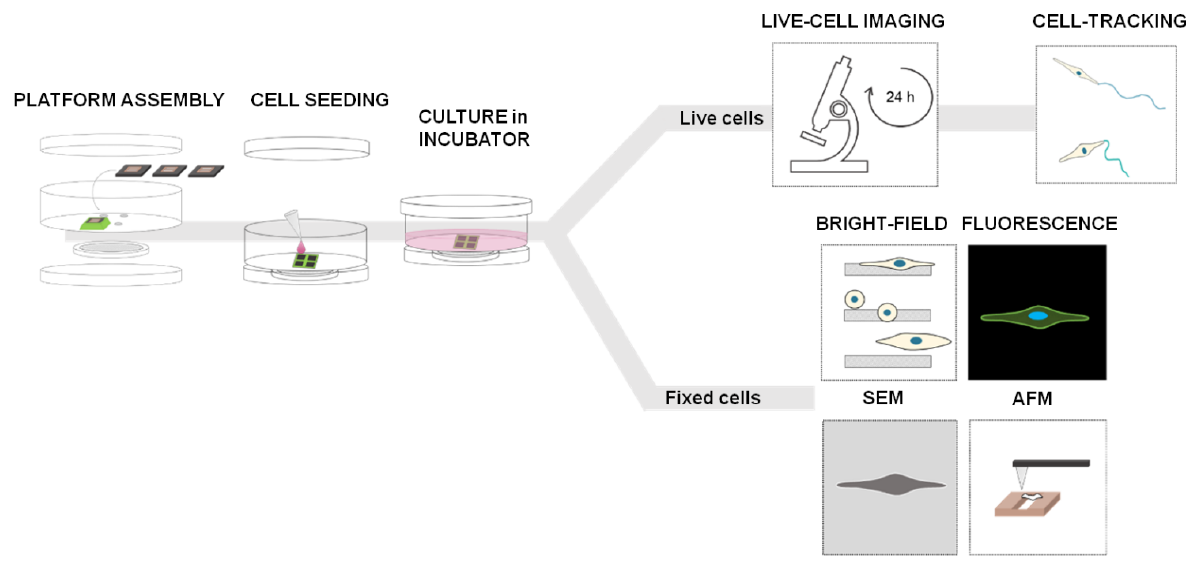
Figure 2. Experimental workflow with the 2D micro-patterned system—4 holes are created on the bottom of a commercial petri dish (35 mm of diameter) using the laser cutter instrument and each chip is fixed on each hole with a biocompatible glue with the top side facing up; cell seeding—a 25 µ L drop of cell suspension is placed on the chip surface and incubated for 20 min in incubator (37 ◦ C and 5% CO 2 ) to allow cells to adhere, while the bottom side beyond the gap is kept dry; the petri-dish is filled with the medium (2 mL final volume) and the chamber is sealed using a petri dish cap on the bottom to ensure sterile condition; for live cell analysis, samples were left in the incubator (5% CO 2 , 37 ◦ C) for 12 h and then observed with the Live-Cell-Imaging Instrument for the next 12 h; for fixed cell analysis, cells were fixed 24 h after incubation and analyzed using various microscopy